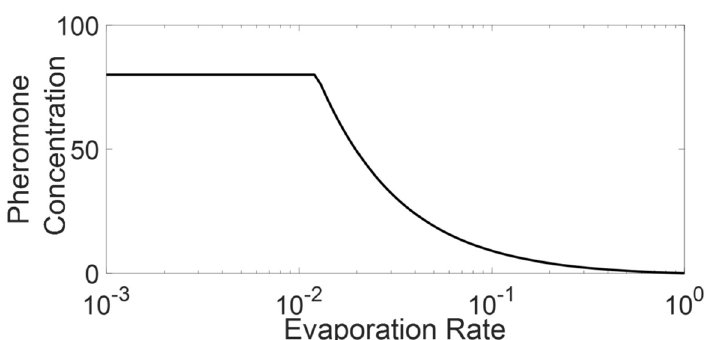
Figure 5. Approximate pheromone concentration at the end of the aggregation scenario ( t M ) based on Equation (9) against evaporation rate is presented (for the calculations τ = 1 p units / time step , σ sat = 80 p units / cell )